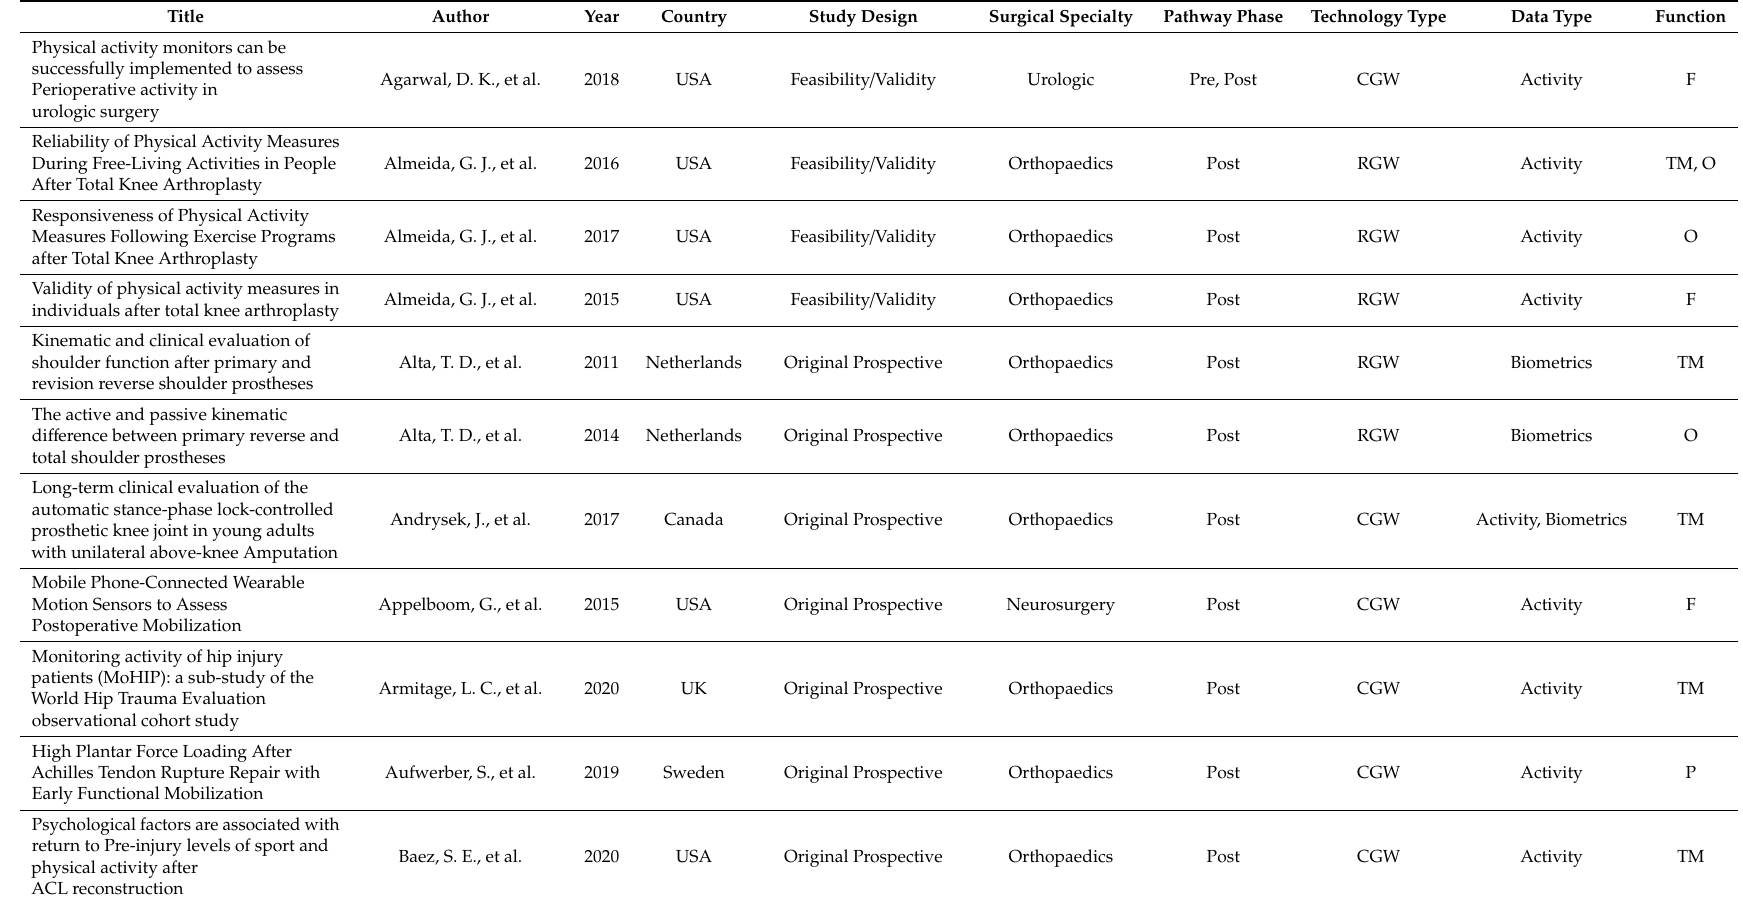
Table A2. Final Study Set including study characteristics, clinical characteristics, technology / data characteristics and functional